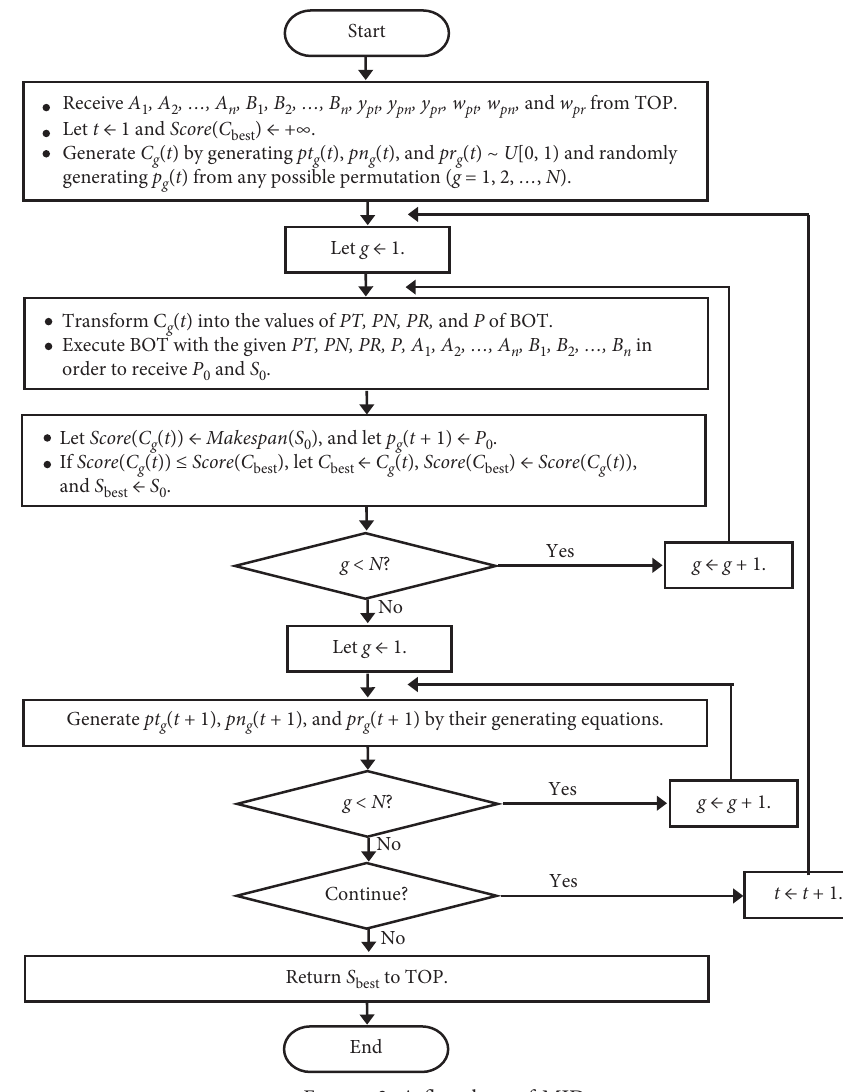
Figure 3: A flowchart of